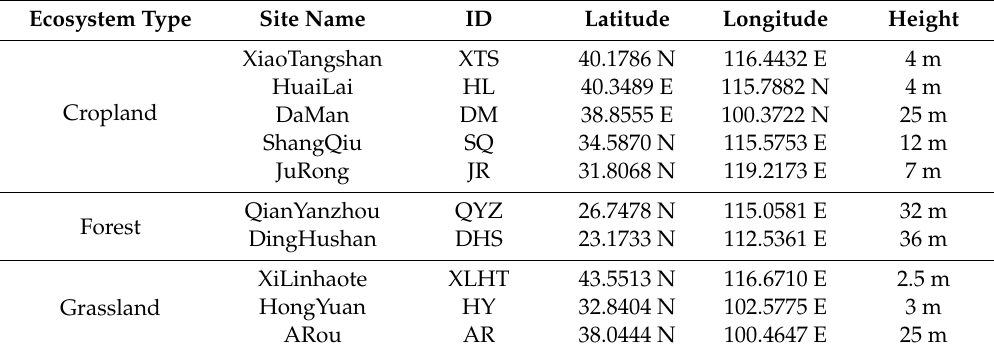
Table 1. Details of the eddy covariance (EC) flux sites with solar-induced chlorophyll fluorescence (SIF) measurement (SIFSpec) mounted on the